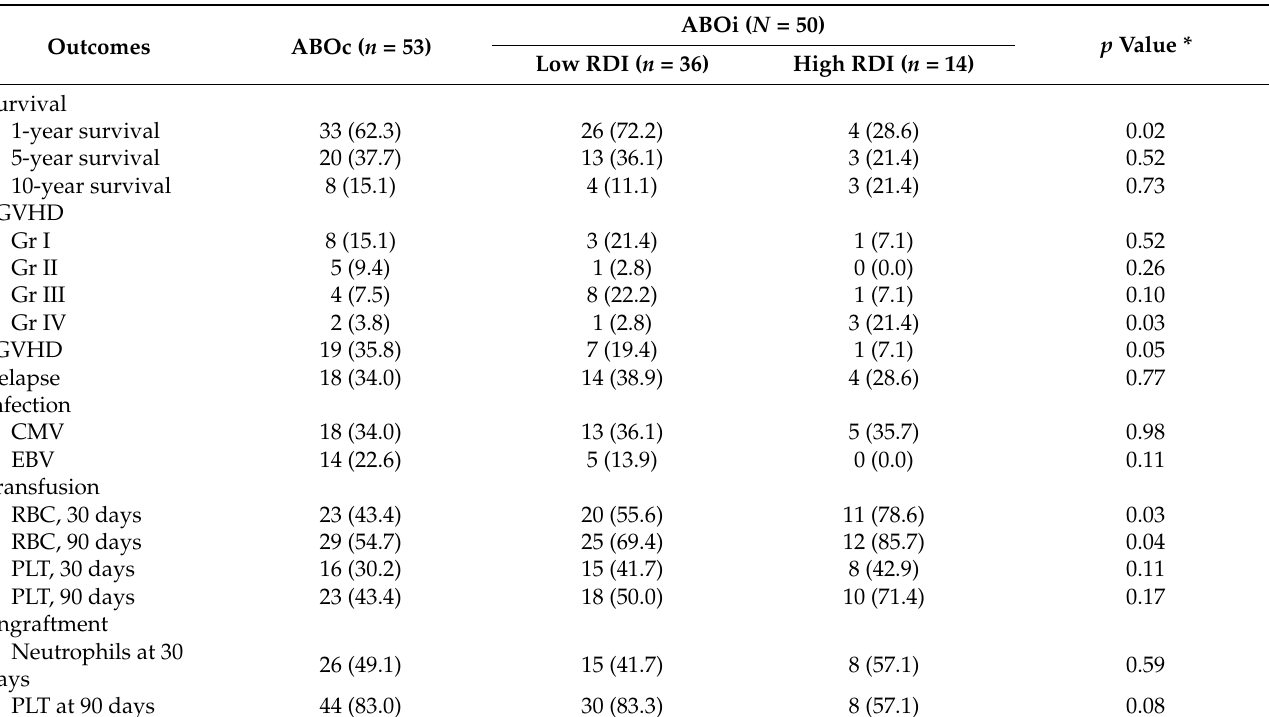
Table 2. Comparison of clinical outcomes among the ABOc group, the ABOi with low RDI group, and the ABOi with high RDI group.